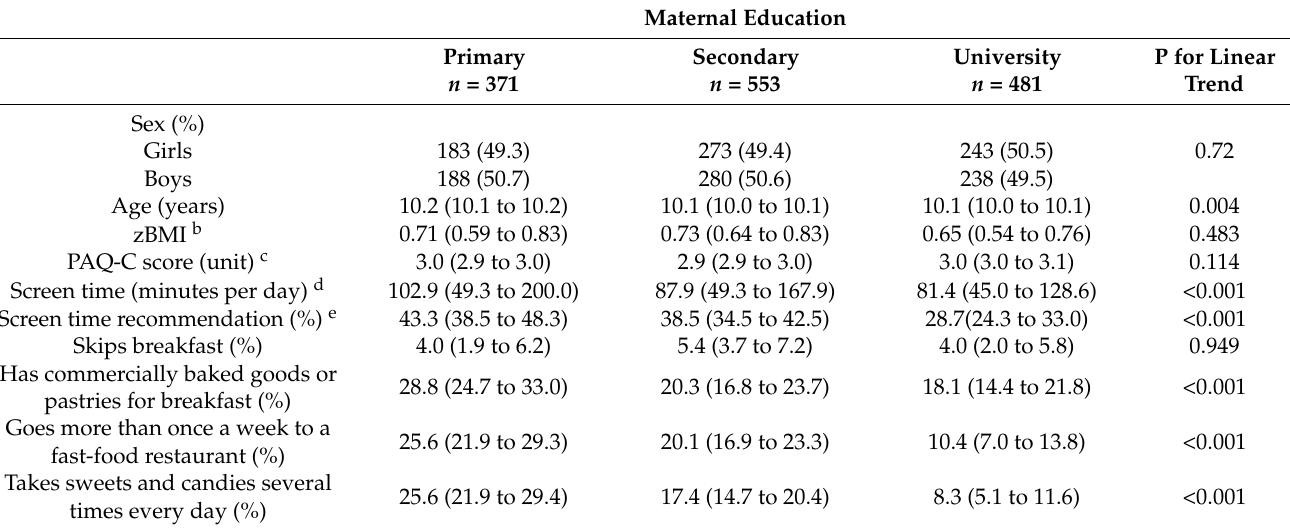
Table 1. Baseline characteristics of the study population across levels of maternal education ( n = 1405) a